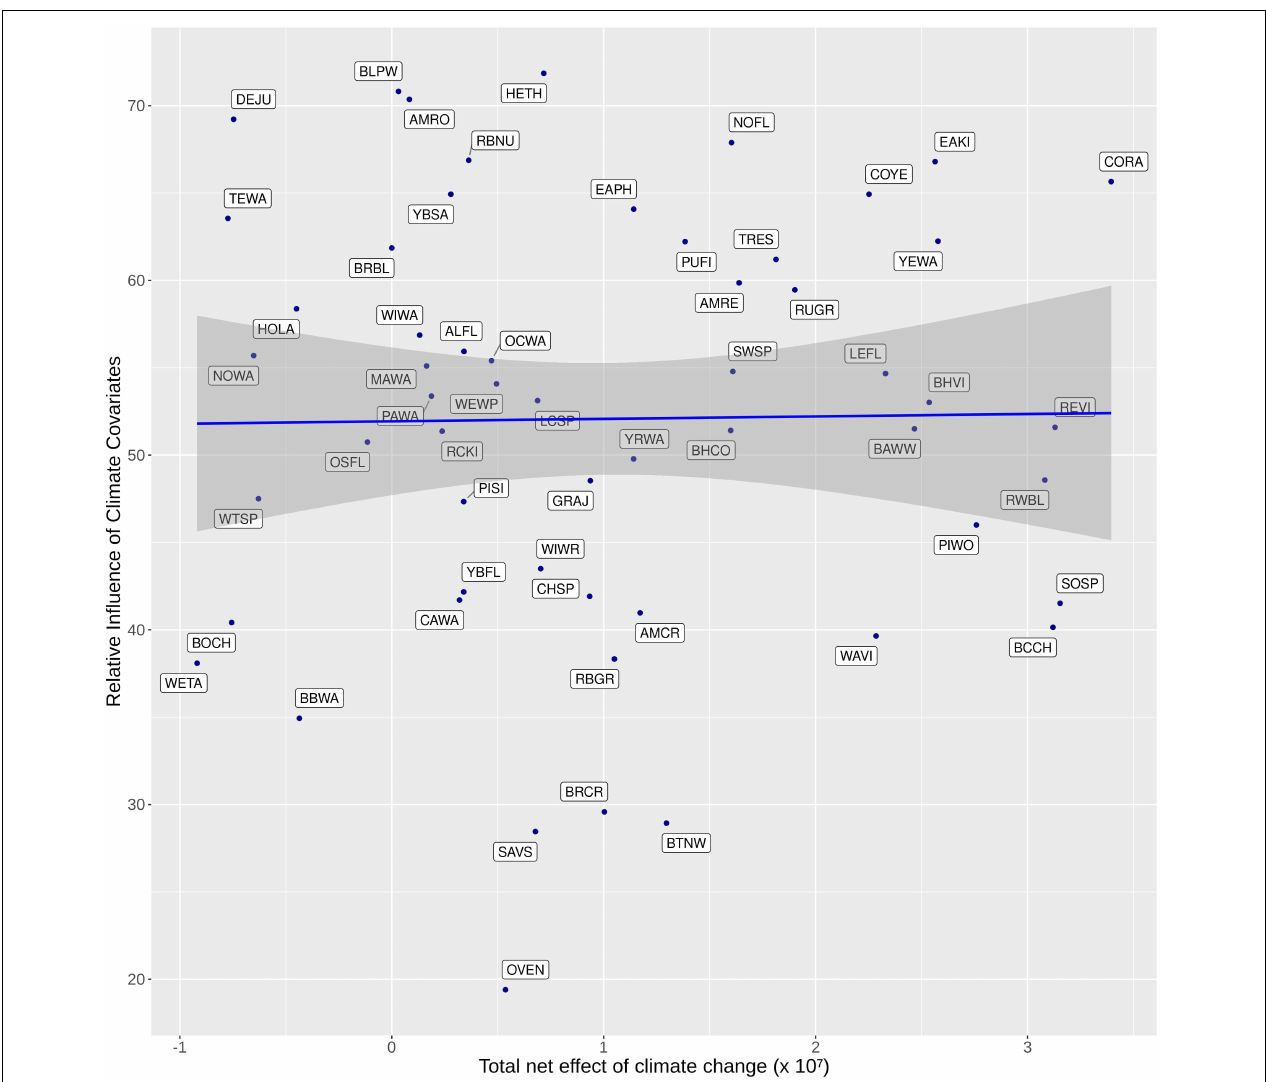
FIGURE 8 | Non-significant correlation (blue line) between relative importance of climate covariates in the climate-sensitive avian species distribution models and total net effect of climate change in terms of area – calculated as the difference of the area affected by climate change calculated between climate-sensitive and non-climate-sensitive predictions in 2100 – for 64 boreal landbird species within the Bird Conservation Region 6 within the Northwest